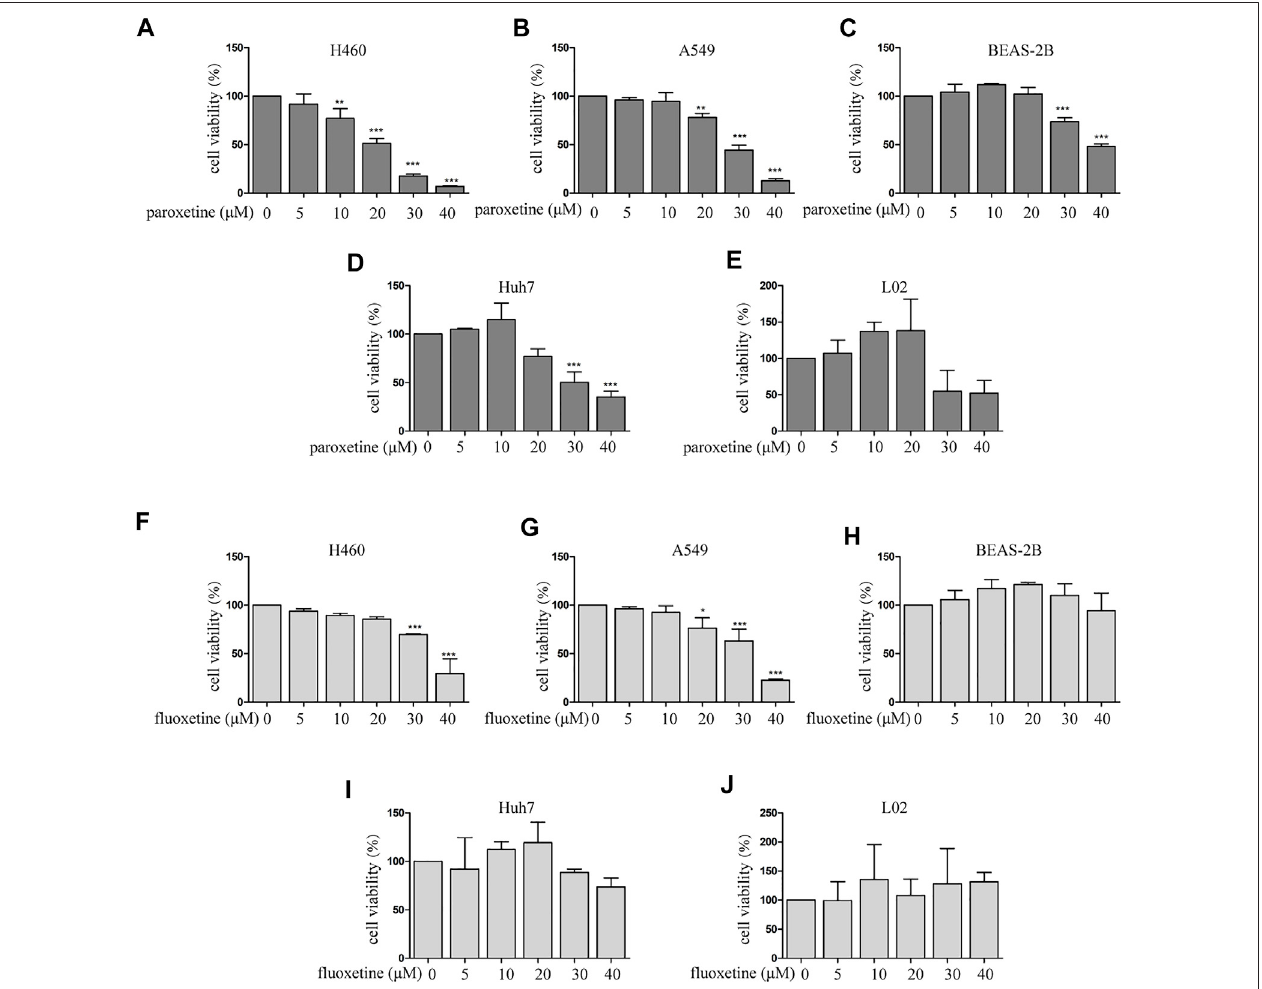
FIGURE1| Comparisonofparoxetineand fl uoxetineforanti-proliferationeffectinmultiplecelllines. (A – E) Lungcancercells(H460andA549),normallungepithelial cells (BEAS-2B), human hepatoma cell line (Huh7), and normal liver cell line (L02) were treated with paroxetine (0, 5, 10, 20, 30, and 40 μ M) for 24 h. CCK8 was used to measure cell viability. (F – J) H460, A549, BEAS-2B, Huh7, L02 cells were treated with fl uoxetine (0, 5, 10, 20, 30, and 40 μ M) for 24 h, CCK8 was used to measure cell viability. Data are presented as mean ± SD; * p < 0.05, ** p < 0.01, *** p < 0.001.